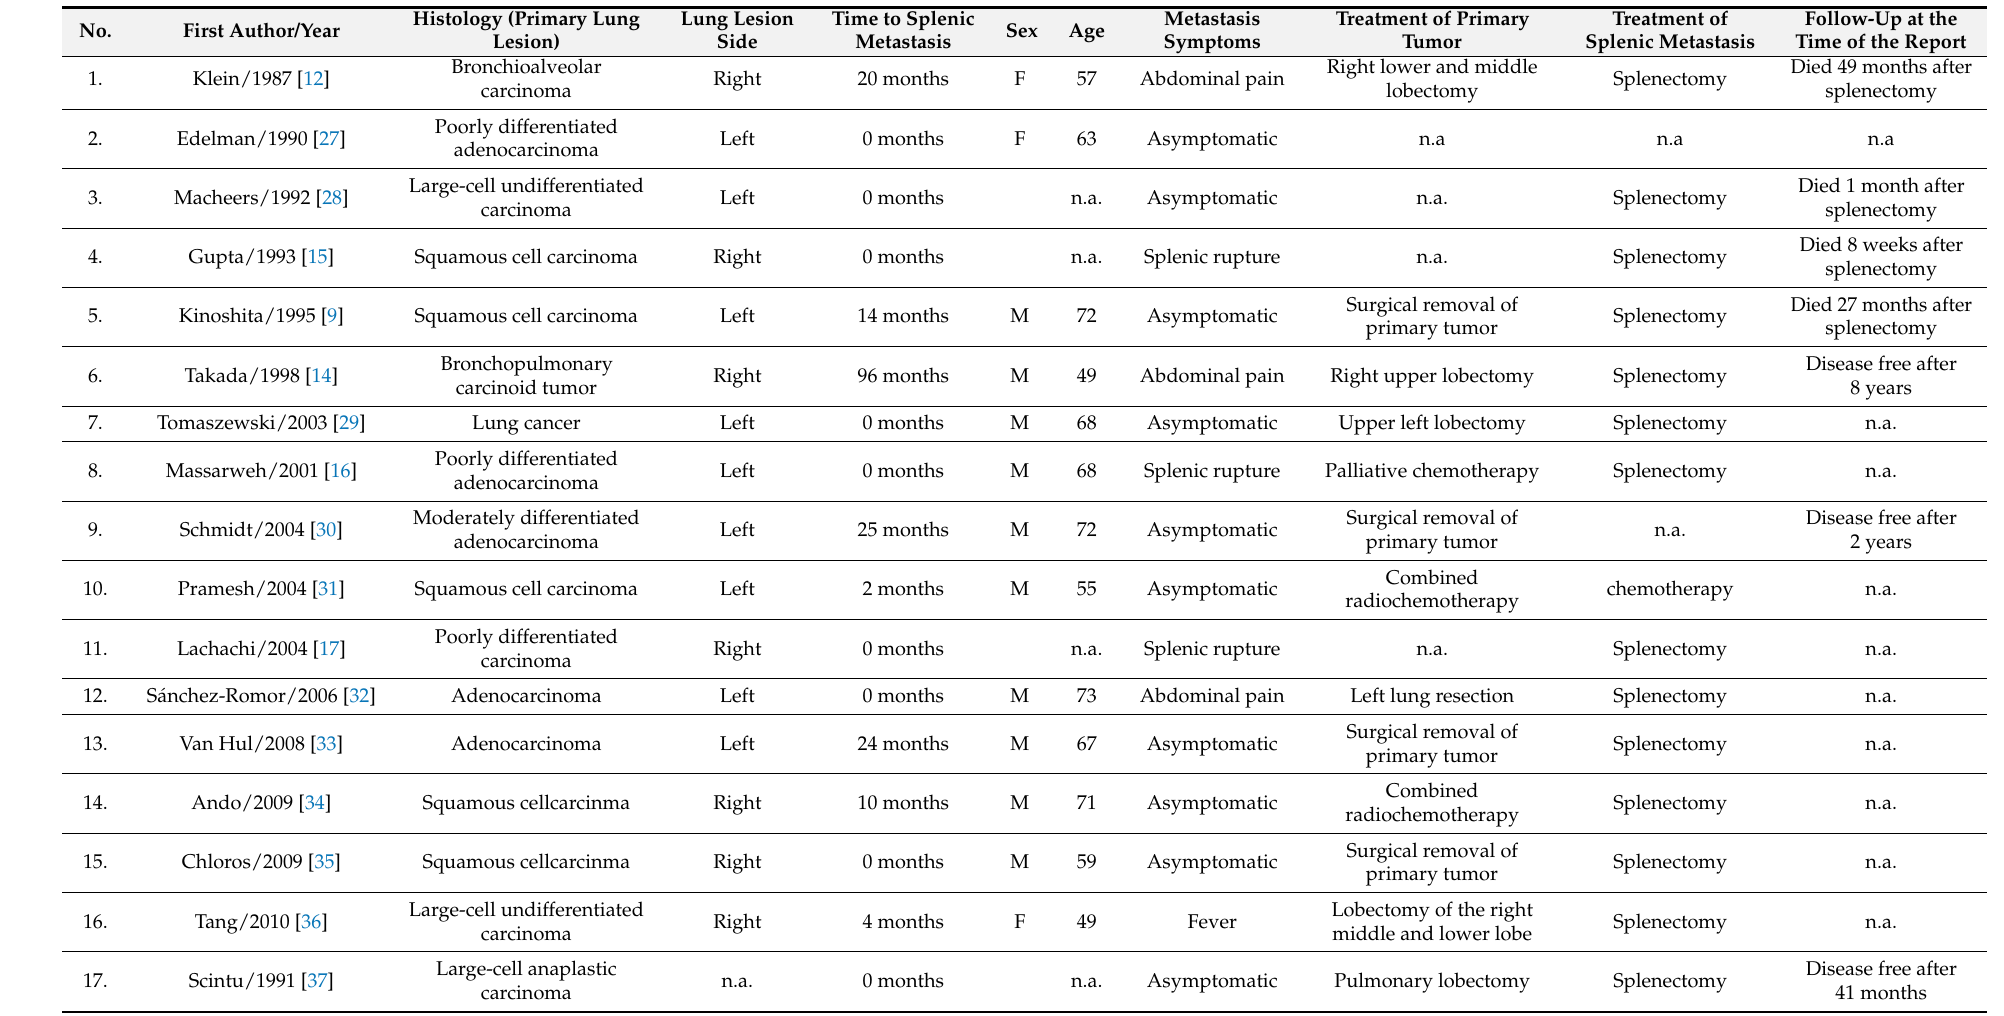
Table 1. Characteristics of patients who developed isolated splenic metastasis from lung